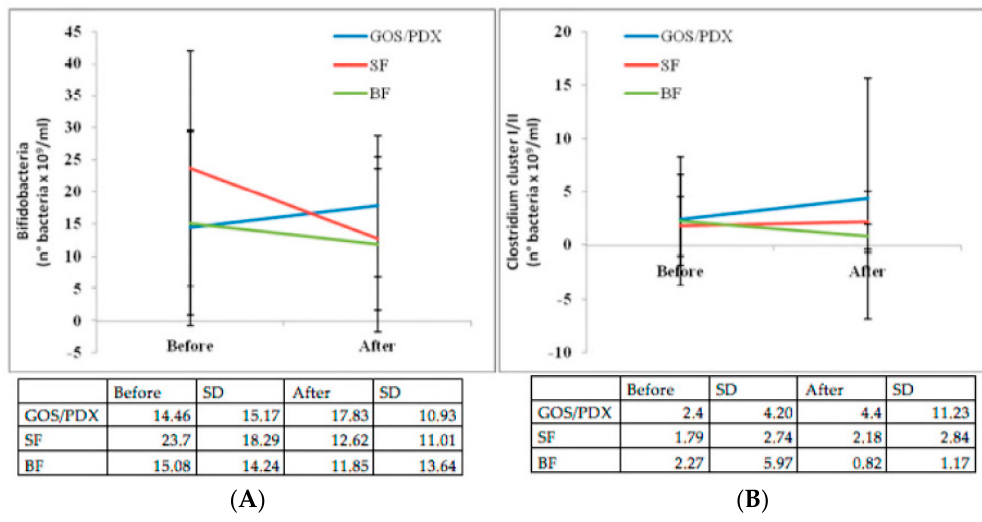
Figure 4. Bifidobacteria load ( A , on the left) and Clostridium cluster I/II load ( B , on the right) over time in the three nutritional groups (PF: prebiotic formula; SF: standard formula; BF: breastfeeding; SD: standard deviation).